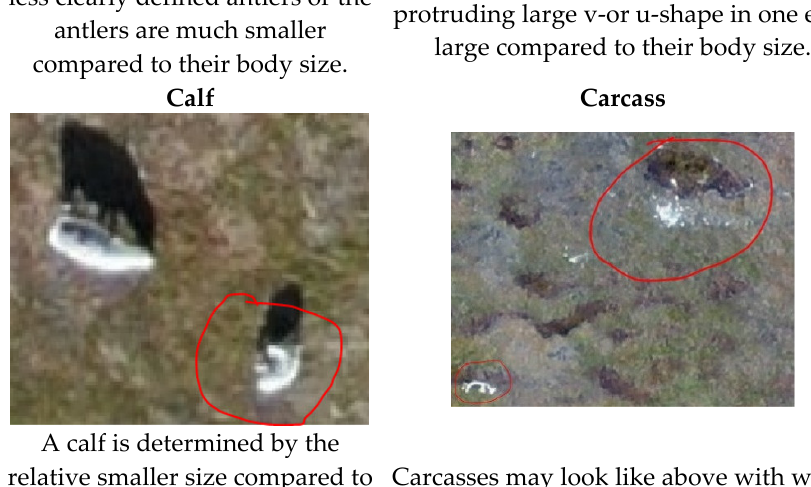
Figure A5. A full-scale image like the one you will see when you go through the images and classify reindeer into one of the five categories in Figure A7. Do you see a reindeer? Try to remember the size of the reindeer relative to the full-scale image. If you see anything that resembles a reindeer, you can zoom in using the buttons on the left. For more information about the software (other than what is in this protocol) check out the DotDotGoose QuickGuide in the folder or this video tutorial on how to use the software: https://www.youtube.com/watch?v=VGxTiQHx4Lc (accessed on 7 December 2020). Appendix C.2. Download Software and Get Started!  Save and extract the ‘Reindeer_counting_drone_imagery.zip’ to your computer or hard disk. The folder and metadata require about 4 GB of space so make sure you have enough.